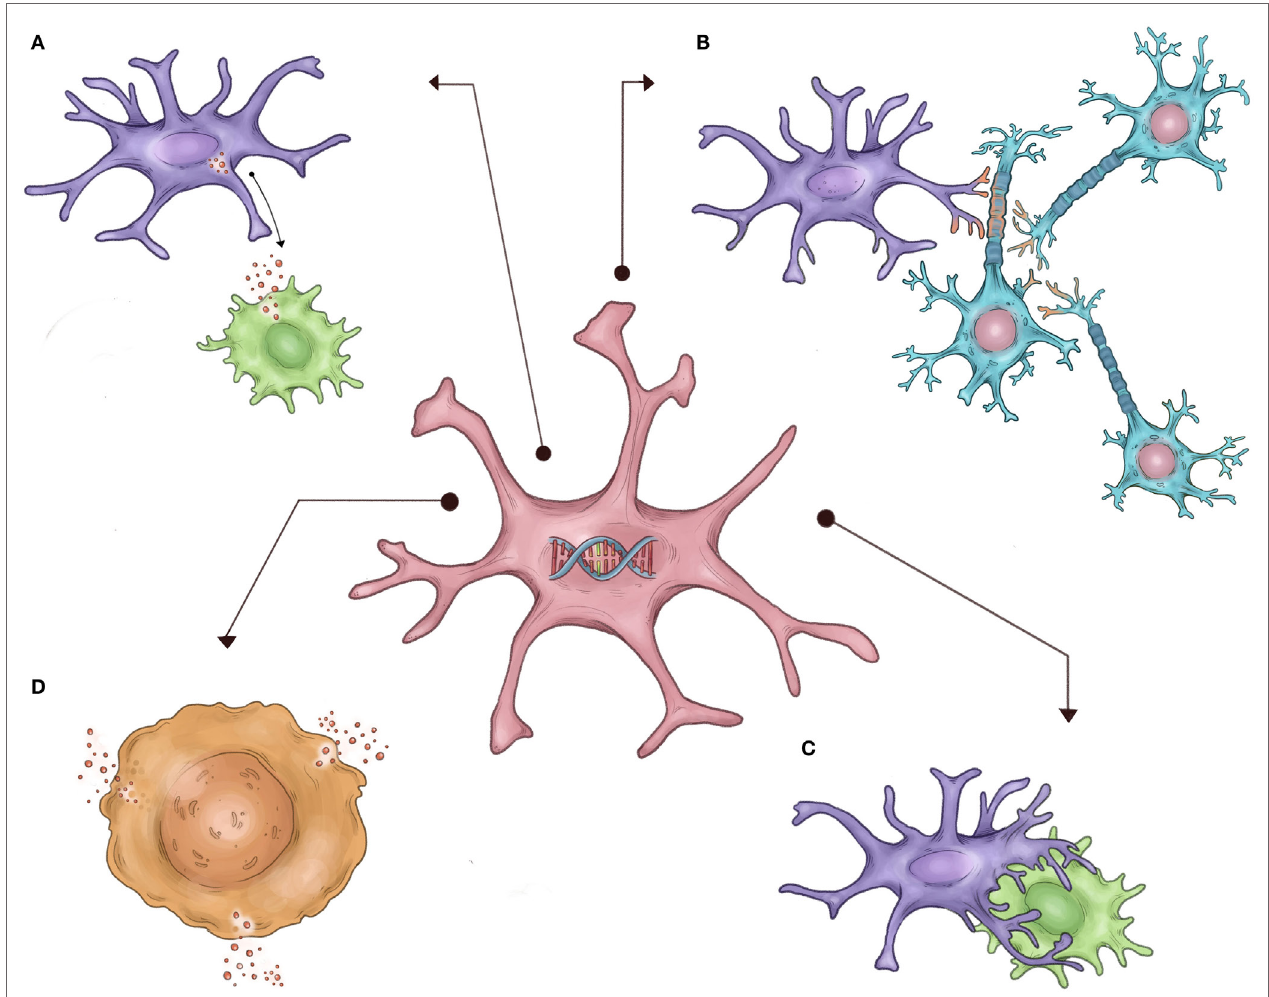
FiGUre 1 | schematic representation of hypothesized non-immune microglial contributions to asd, as described in the text. It is proposed that inherited defects in the microglial genome/epigenome in autistic patients (center) result in abnormal or exaggerated execution of normal developmental microglial functions, such as (a) abnormal secretion of trophic factors necessary for normal neuronal growth, (B) incorrect synaptic pruning, (C) failure of appropriate apoptosis of neurons, and (d) exaggerated activation and cytokine